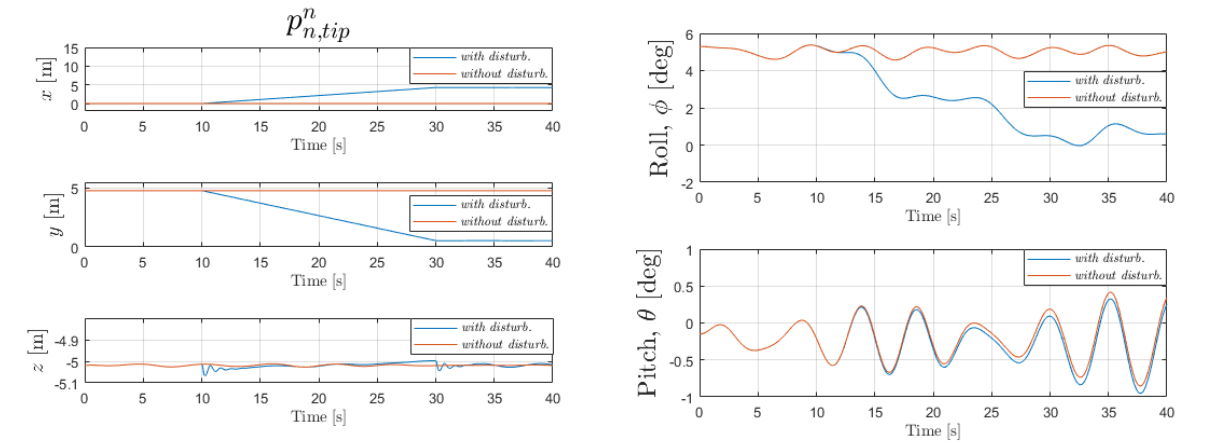
Figure 6: Upper window: Roll φ angle of the vessel due to the crane tip trajectories illustrated in Figure 5. Lower window: Pitch θ angle of the vessel due to the crane tip trajectories illustrated in Figure 5.